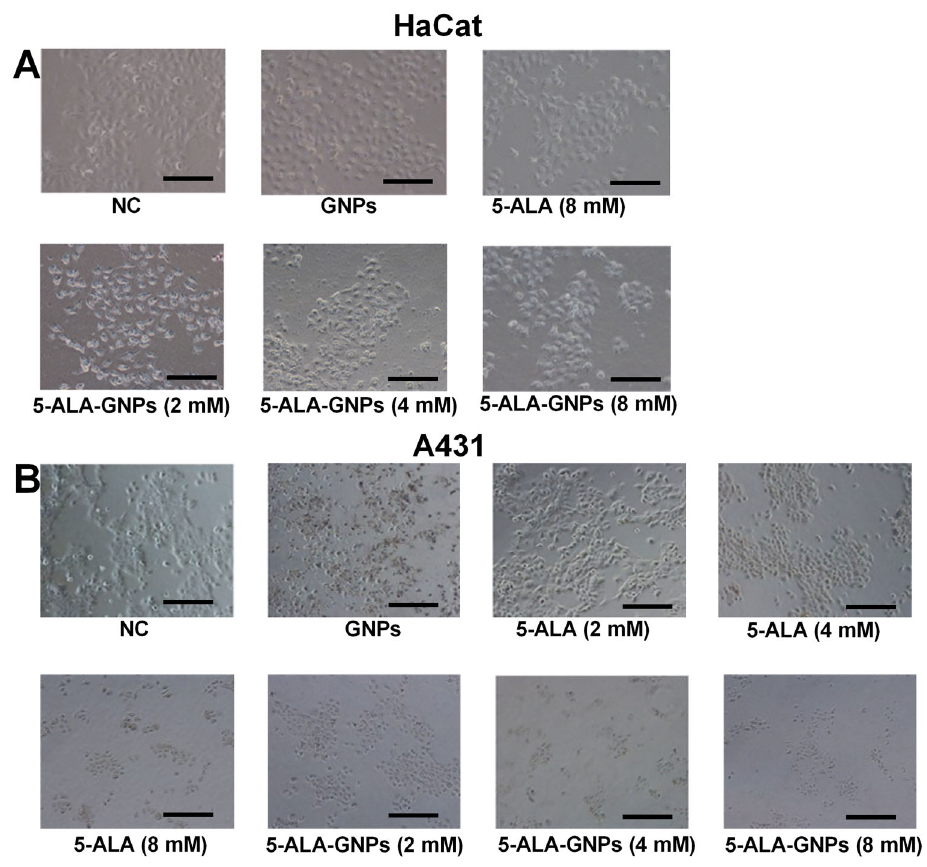
Figure 2. Morphology of HaCat and A431 cells after in vitro photodynamic therapy (PDT) with 5-aminolevulinic acid (5-ALA) or 5-ALA- gold nanoparticles (GNPs). A , Morphology of HaCat cells after being treated with phosphate-buffered saline (PBS) (negative control (NC)), GNPs, or in vitro PDT with 5-ALA (8 mM) or 5-ALA-GNPs (2, 4, and 8 mM). Scale bars, 200 m m. B , Morphology of A431 cells after being treated with PBS (NC), GNPs, or in vitro PDT with 5-ALA (2, 4, and 8 mM) or 5-ALA-GNPs (2, 4, and 8 mM). Scale bars, 200 m